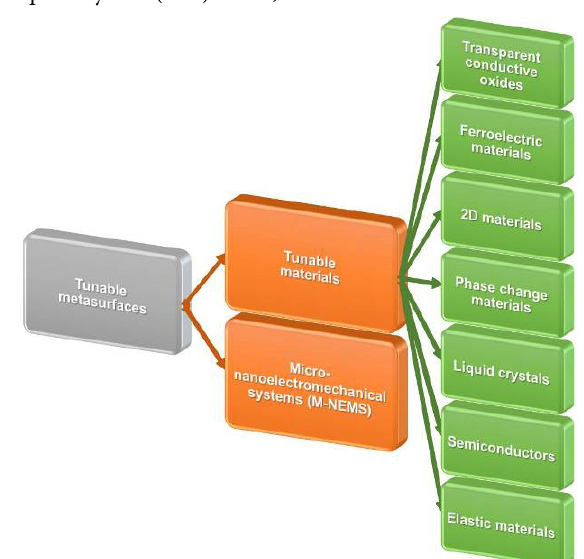
Fig. 1 | Schematic art view of the different mechanisms in tunable